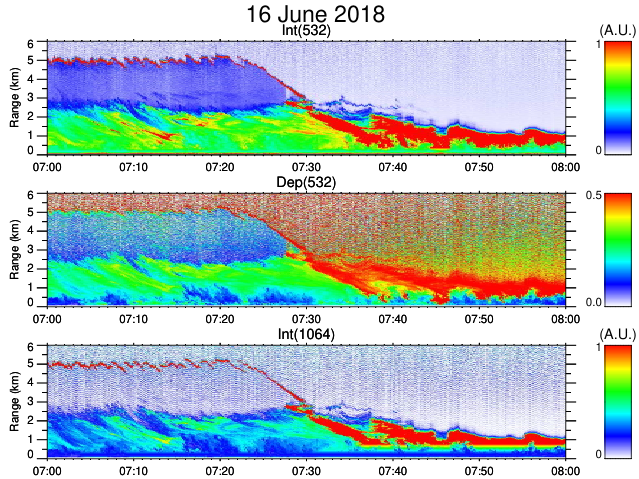
Figure 2. Time-range plots of backscatter intensity (arbitrary units, A.U.) observed by the SVO lidar during 07:00–08:00 JST on 16 June 2018 at: 532 nm ( top ); depolarization ratio at 532 nm ( middle ); and backscatter intensity at 1064 nm ( bottom ). The vertical axes correspond to the distance along the line of sight from the lidar equipment to the